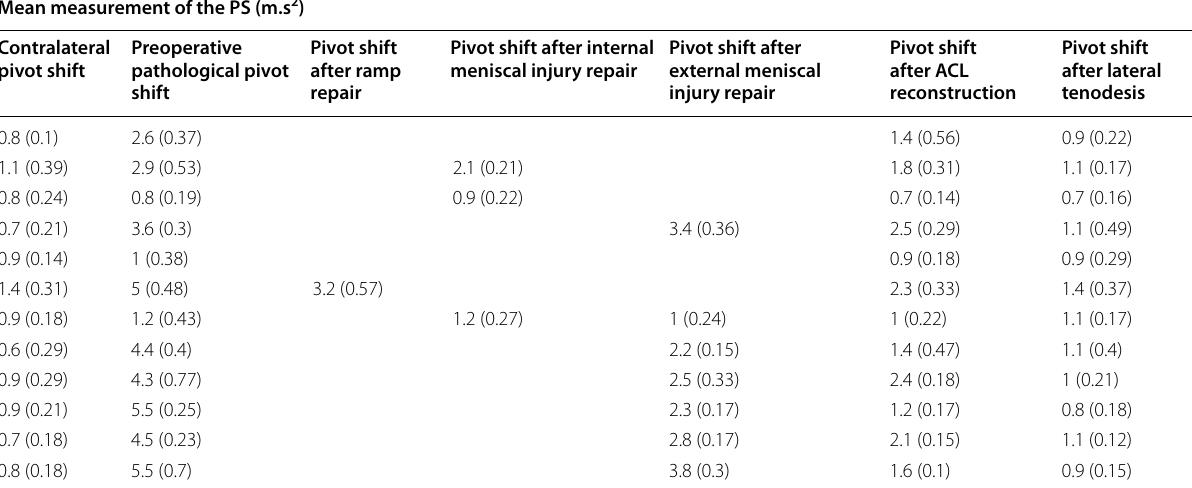
Table 1 Average measurements (of both examiners) and standard deviation of pivot shift during the different stages of intervention Mean measurement of the PS (m.s 2 )